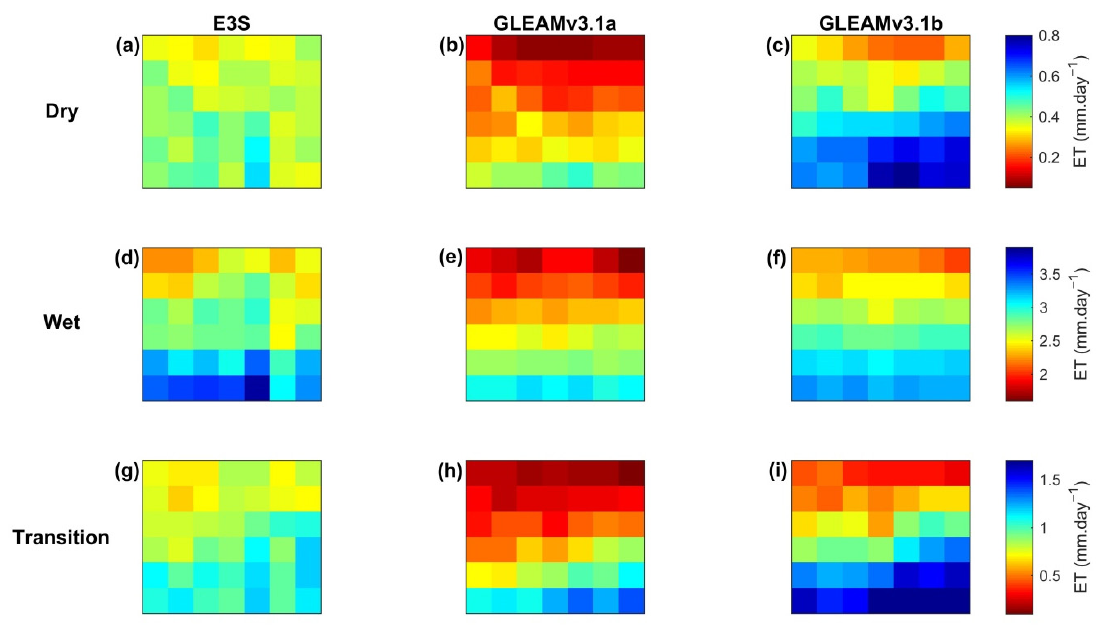
Figure 13. Maps of mean seasonal ET d at 0.25° resolution, from upscaled E3S ( a,d,g ), GLEAMv3.1a ( b,e,h ), and GLEAMv3.1b ( c,f,i ), for the dry season ( a,b,c ), the wet season ( d,e,f ), and the transition period ( g,h,i ) over 2005–2008. GLEAM: global land evaporation Amsterdam model.